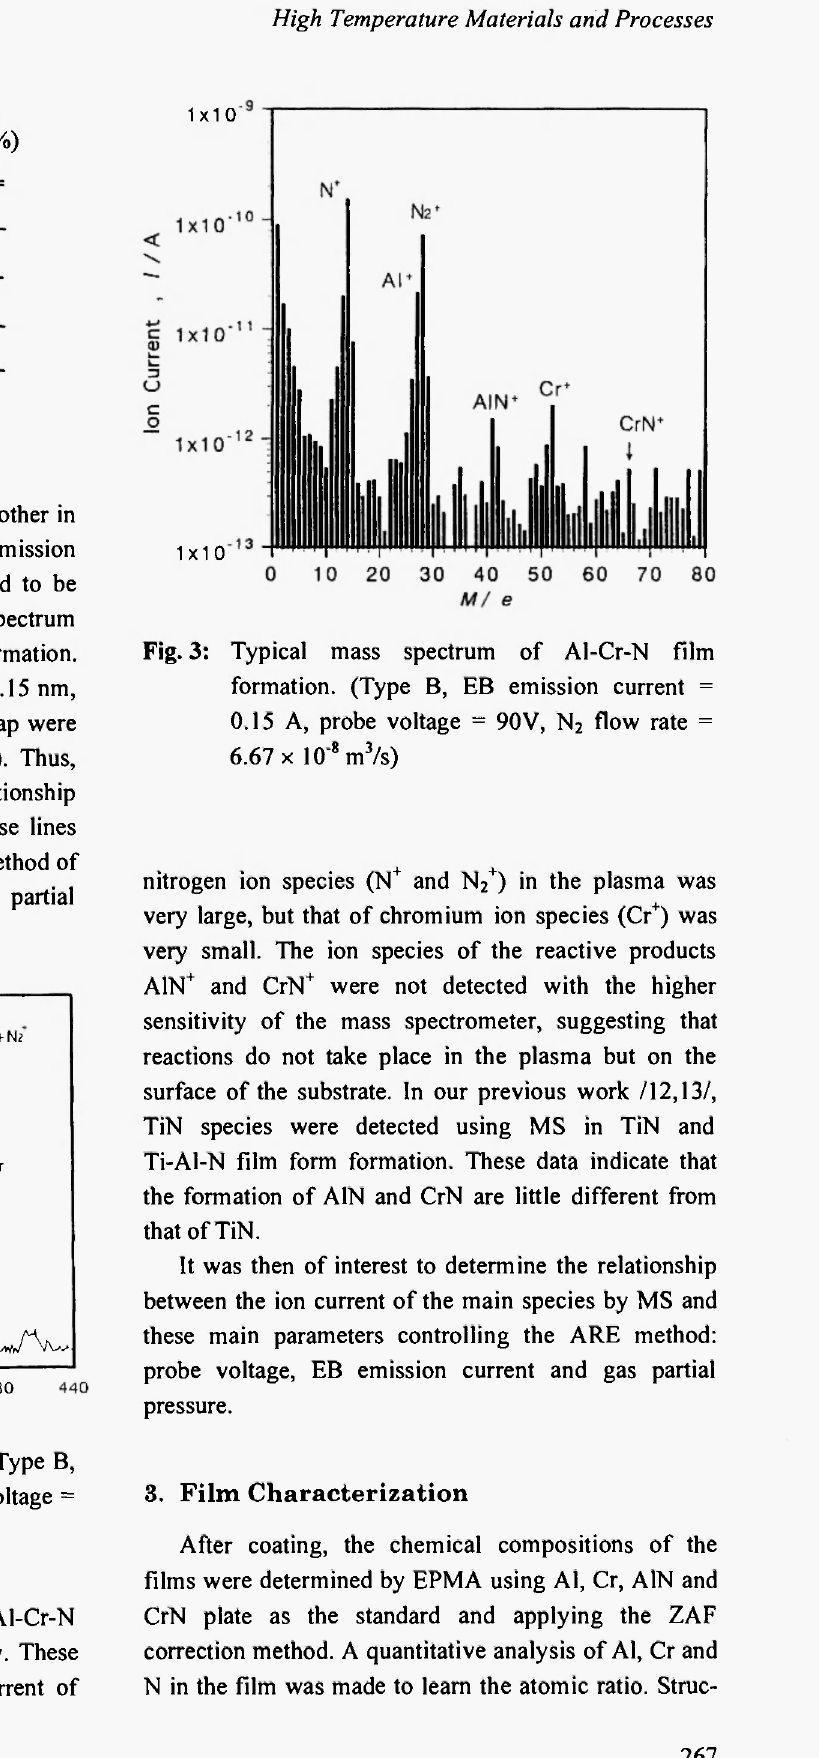
Mass spectra recorded in A IN, CrN and Al-Cr-N film formation are shown in Fig. 3 respectively. These mass spectroscopic data show that the ion current of